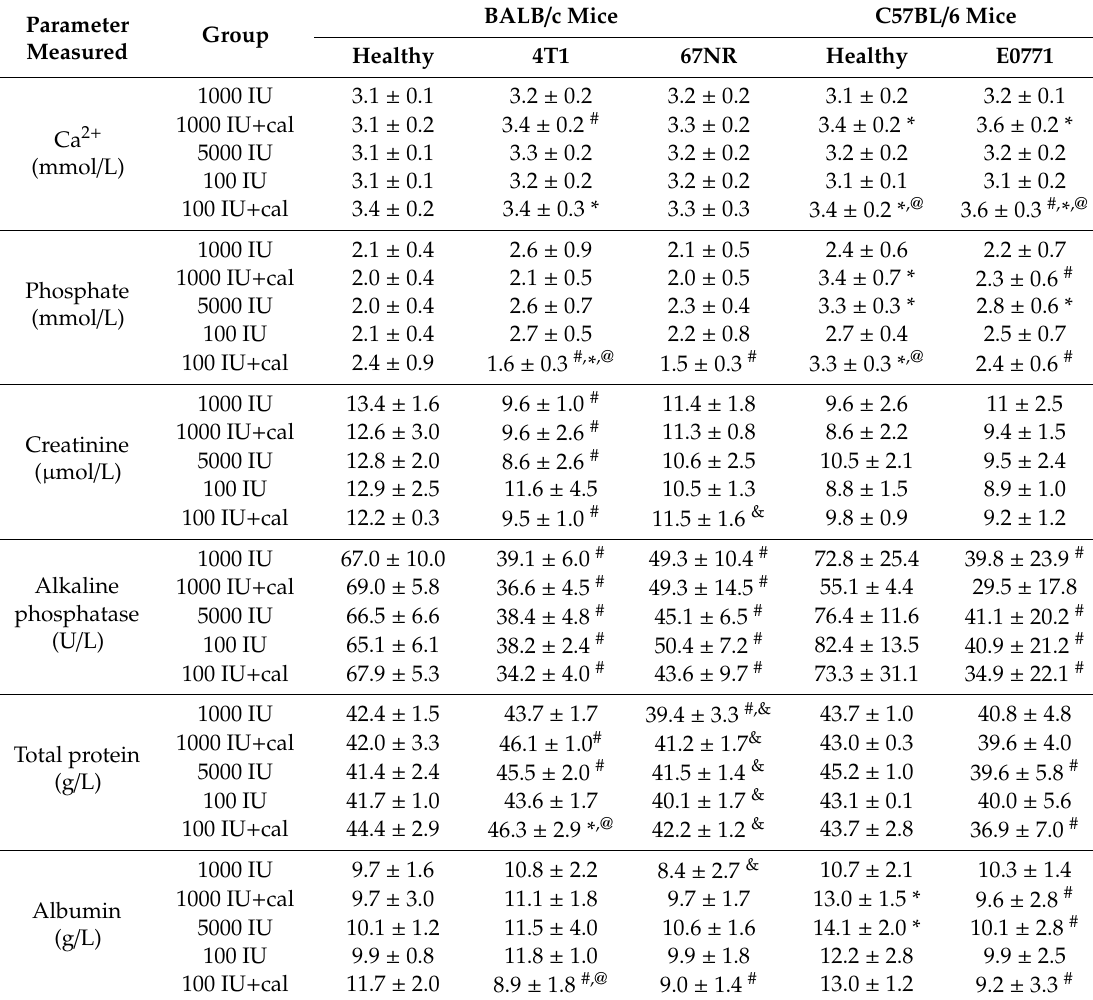
Table 4. Plasma level of selected biochemical parameters of